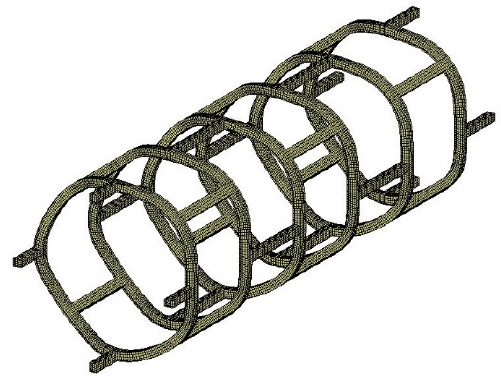
Figure 12. Prototype geometry after discretization .